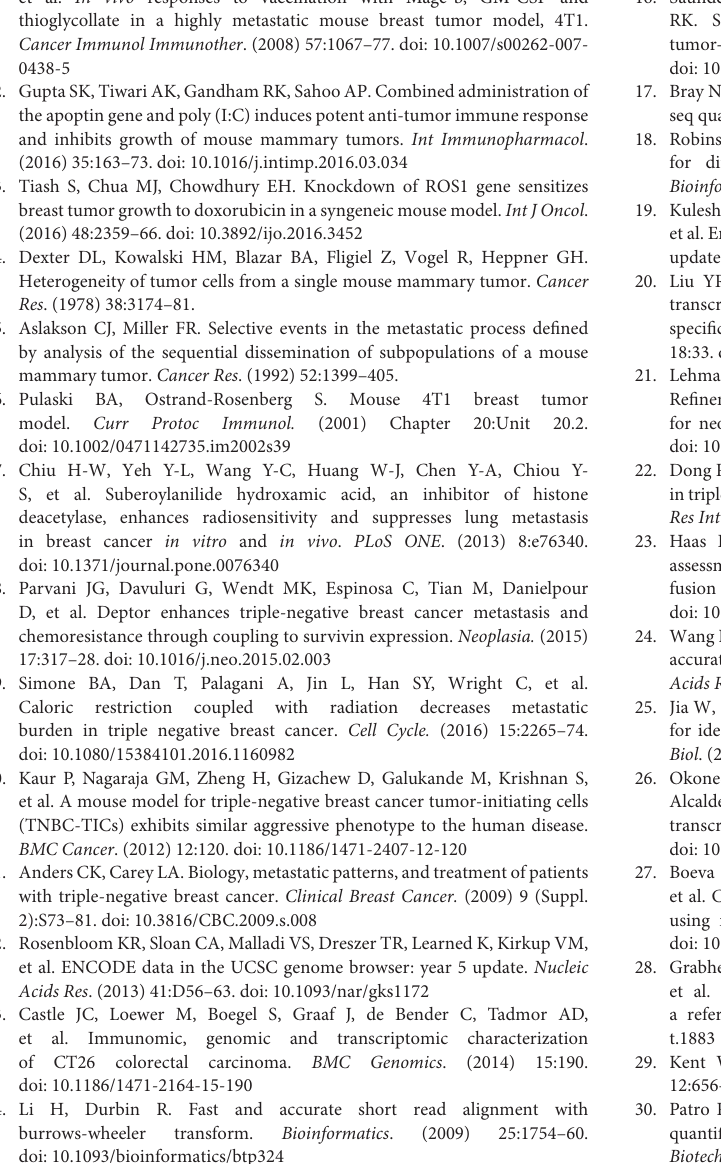
Table S10 | Expression values in TPM of MHC genes in 4T1 and BALB/c tissues. The used reference sequences from the UCSC known genes or Genbank are also listed. Table S11 | Results of immunogenicity testing, including details on mutation, amino acid substitution, the result of the ELISpot assay, the subtype of the T-cell response, and the specificity when compared to a WT